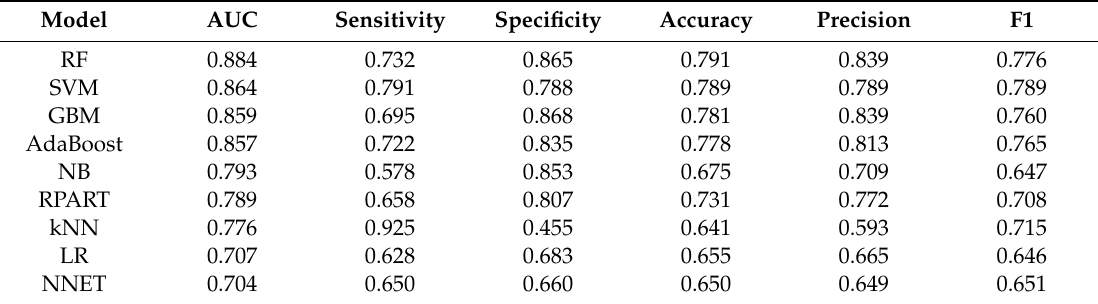
Table 3. Average metrics of nine ML models across all independent